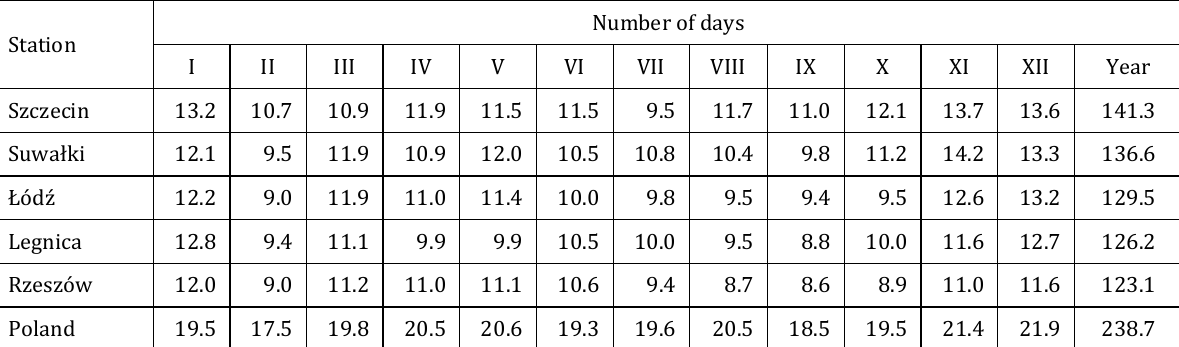
in the period 2006-2015 Number of